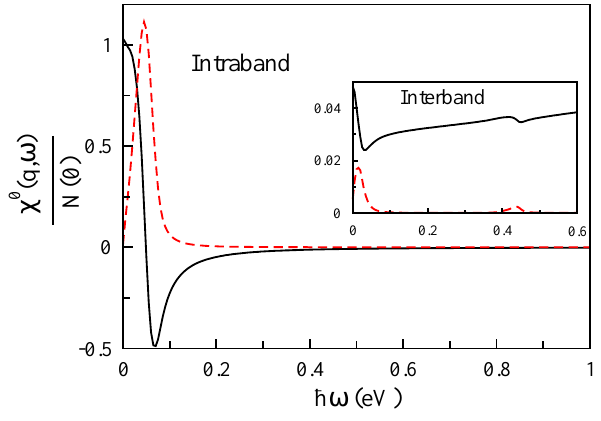
Figure 12. The non-interacting response function in units of the Fermi-level density of states as a function of ¯ h ω of bilayer MoS 2 for q = 0.084 Å − 1